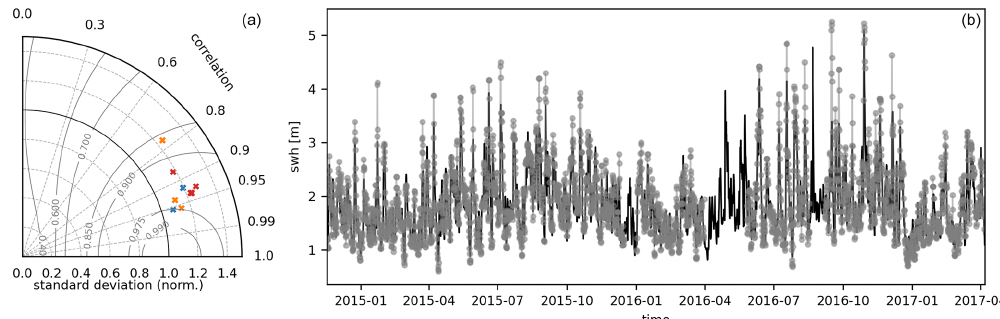
Figure A1. The Taylor diagram (a) summarizes the validation of ERA5 swh results with PNBOIA measurements using the results in the interval between 2012–2019. The markers represent different moorings at Santos (red), Santa Catarina (blue), and Rio Grande (orange) positions, and the gray numbered contours are isolines of skill (Willmott, 1981). Moorings at the same position do not overlap in time. The swh time series (b) exemplifies the ERA5 results (black line) and the measurements (gray dotted line) at the Santos position.